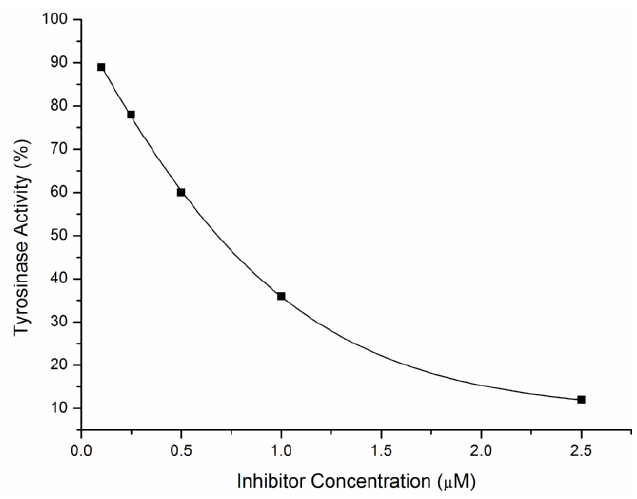
Figure 1. Effect of compound 3d on the diphenolase activity against mushroom tyrosinase for the catalysis of L -DOPA at 25 °C.